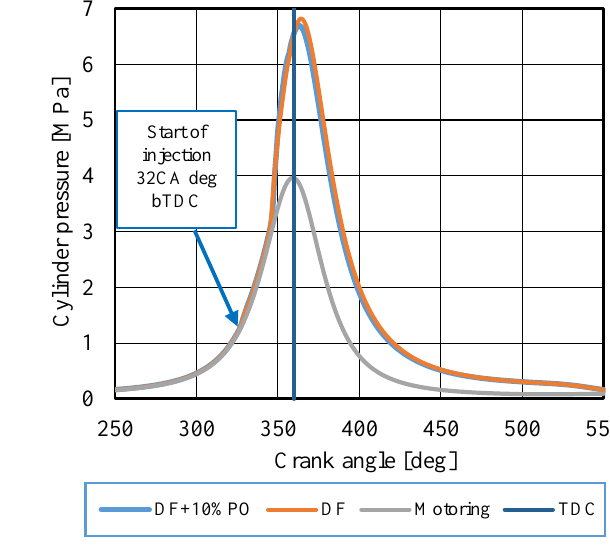
Fig. 7. Cylinder pressure vs. crank angle range 250–550 deg for a variable